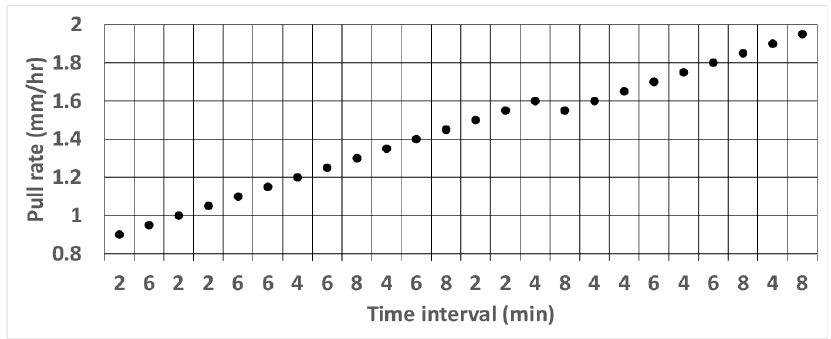
Figure 9. Dynamic pull profile between t = 5 h and t = 7 h.